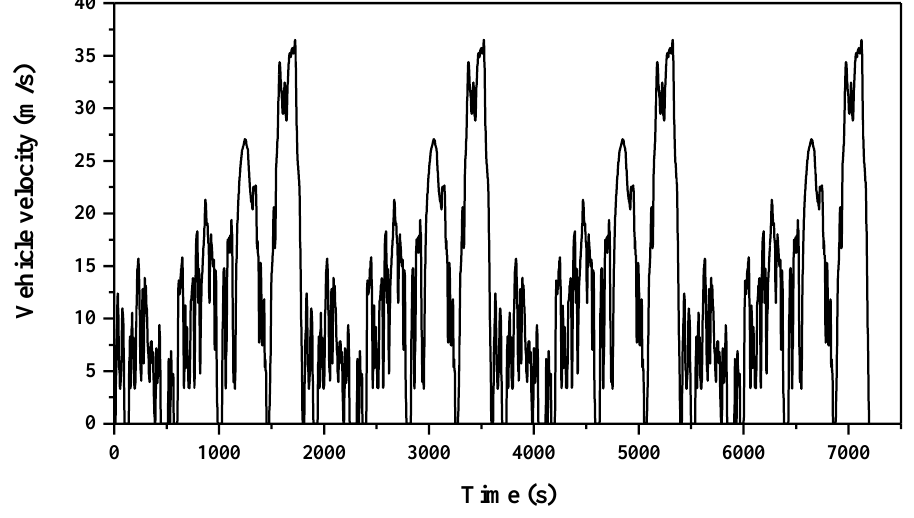
Figure 11. Velocity profile of WLTC cycles.